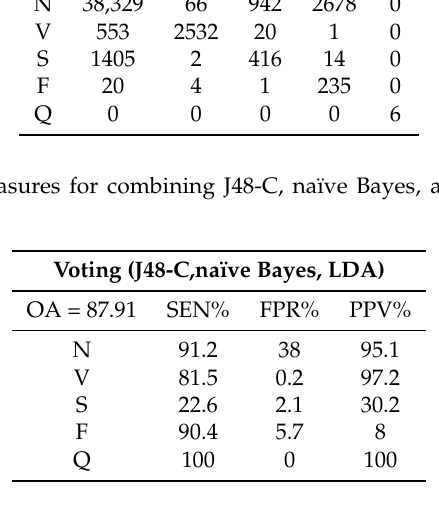
Table 16. Confusion matrices for various classifiers (N, V, and S